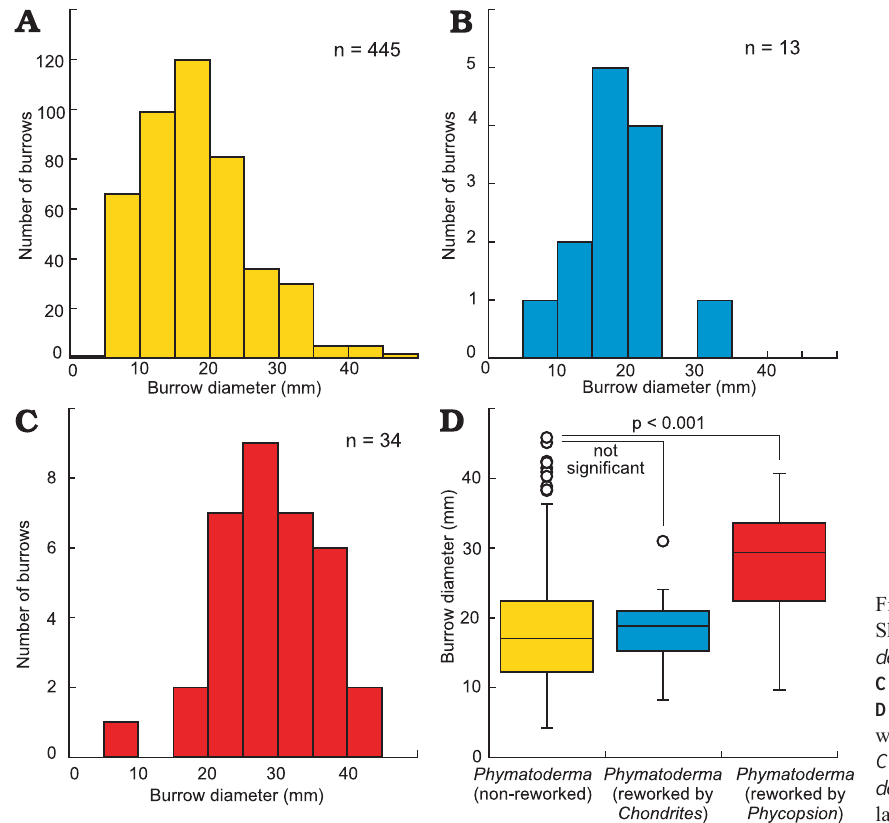
Fig. 5. Size distributions of Phymatoderma from the Shiramazu Formation. A . Non-reworked Phymato- derma . B . Phymatoderma reworked by Chondrites . C . Phymatoderma reworked by Phycosiphon . worked Phymatoderma , and tunnels reworked by Chondrites and Phycosiphon . Note that Phymato- derma reworked by Phycosiphon has significantly larger size. n, number of measured